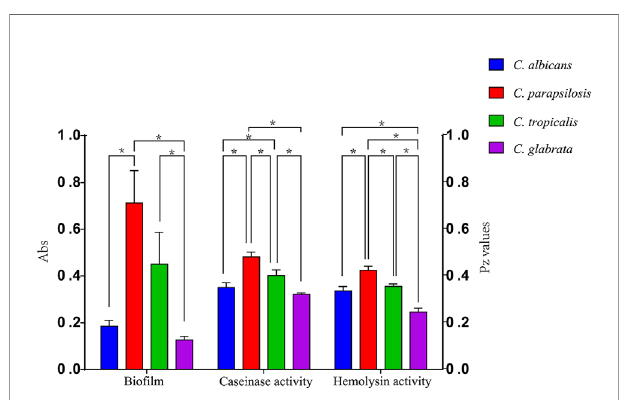
FIGURE 4 | Comparison of the virulence levels (bio fi lm biomass, casein activity and hemolysin activity) of four Candida species. * indicates statistically signi fi cant ( p